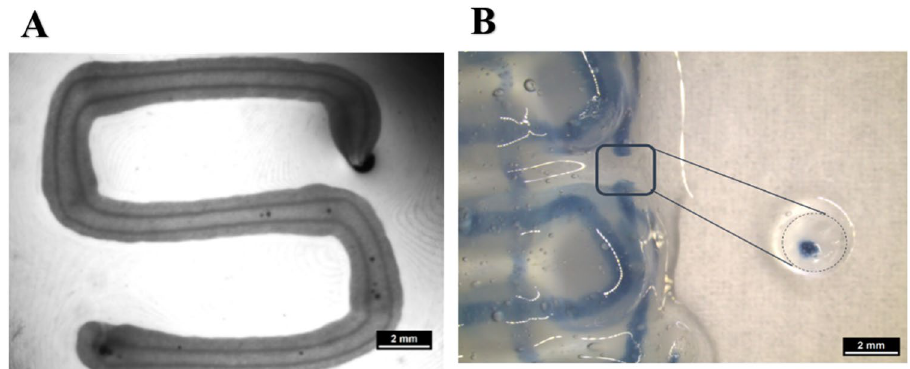
Figure 7. Core–shell plotting using 800 µm needle for shell and 400 µm needle for core. ( A ) Stereo microscopic image of a cell-free core–shell strand, deposited in meandering shape, with clear separation of core (algMC) and shell (algMC + Matrigel) compartments within the strand; scale bar 2 mm. ( B ) Stereo microscopic image of a cell-free, printed scaffold with blue stain in the core for visualizing the continuous core compartment through the coaxial strand; The insert shows a section through the strand segment, cut out from the scaffold scale bar 2 mm.